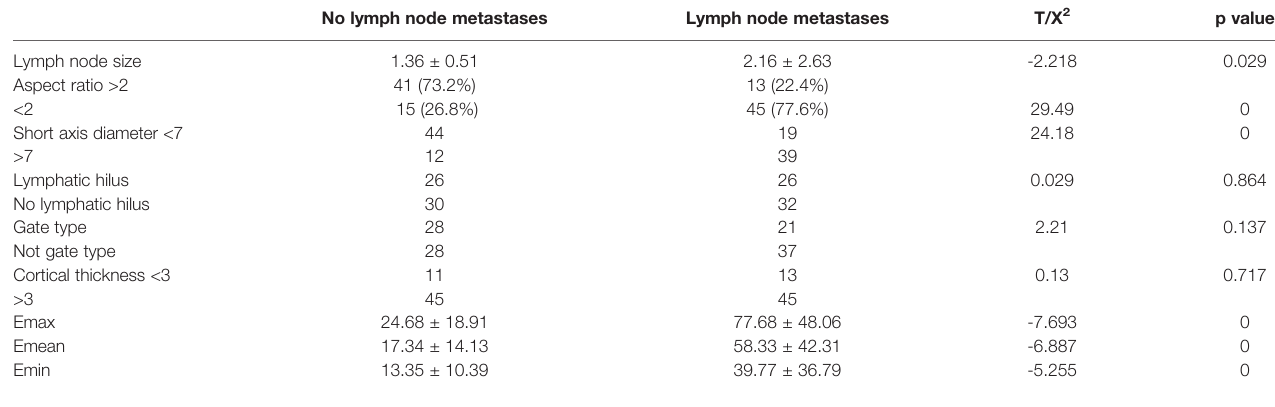
TABLE 2 | Comparison of CUE and SWE elastic modulus between the two groups with/without